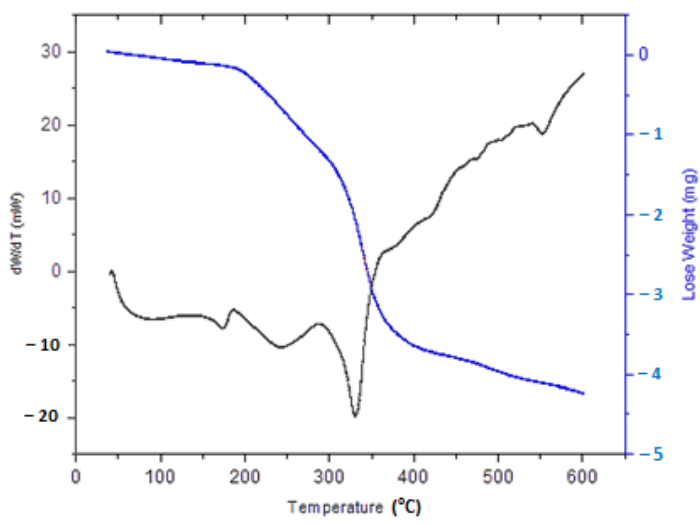
Figure 5. TGA and DSC curves of PUM-RSB.